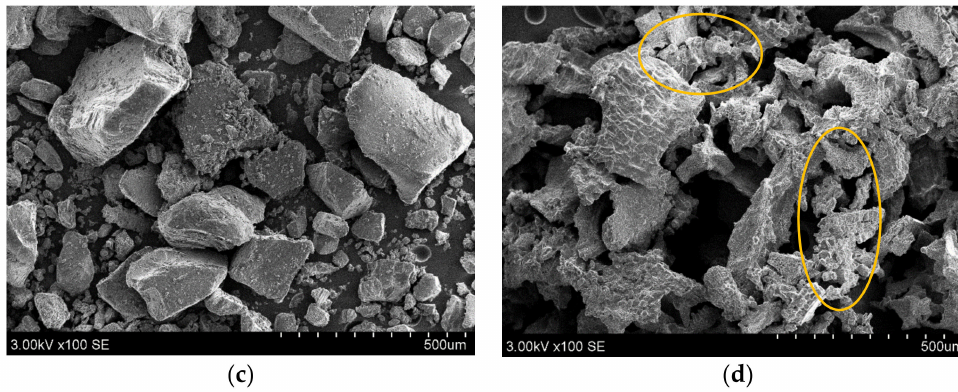
Figure 1. SEM images of C. islandica ( a , b ) and F. esculentum ( c , d ) solid fractions before and after enzymatic hydrolysis.